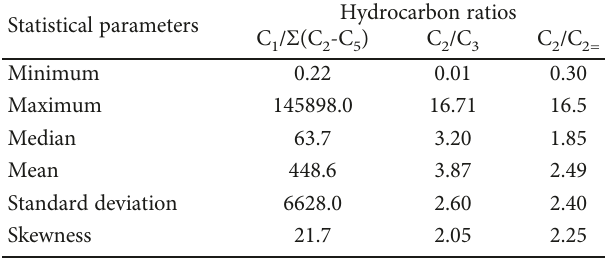
Table 3: Principal statistical parameters of hydrocarbon ratios calculated for analyzed soil gas